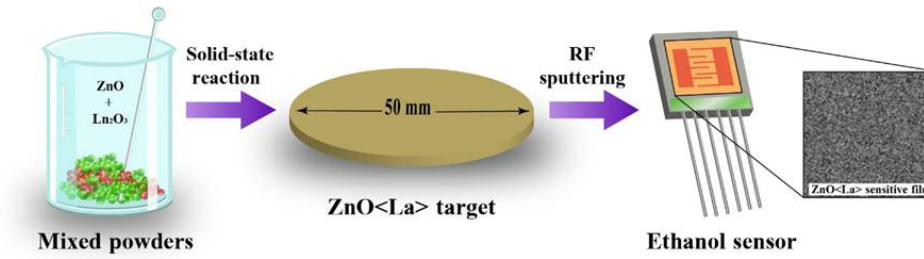
Figure 4. Schematic block diagram of the ethanol sensor fabrication.